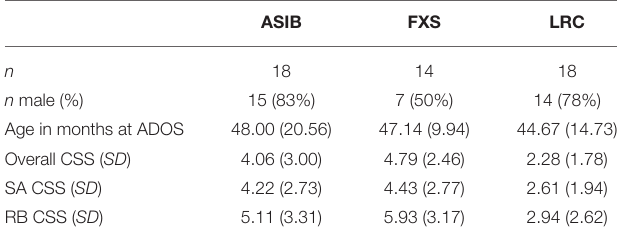
TABLE 1 | ADOS calibrated severity scores by participant